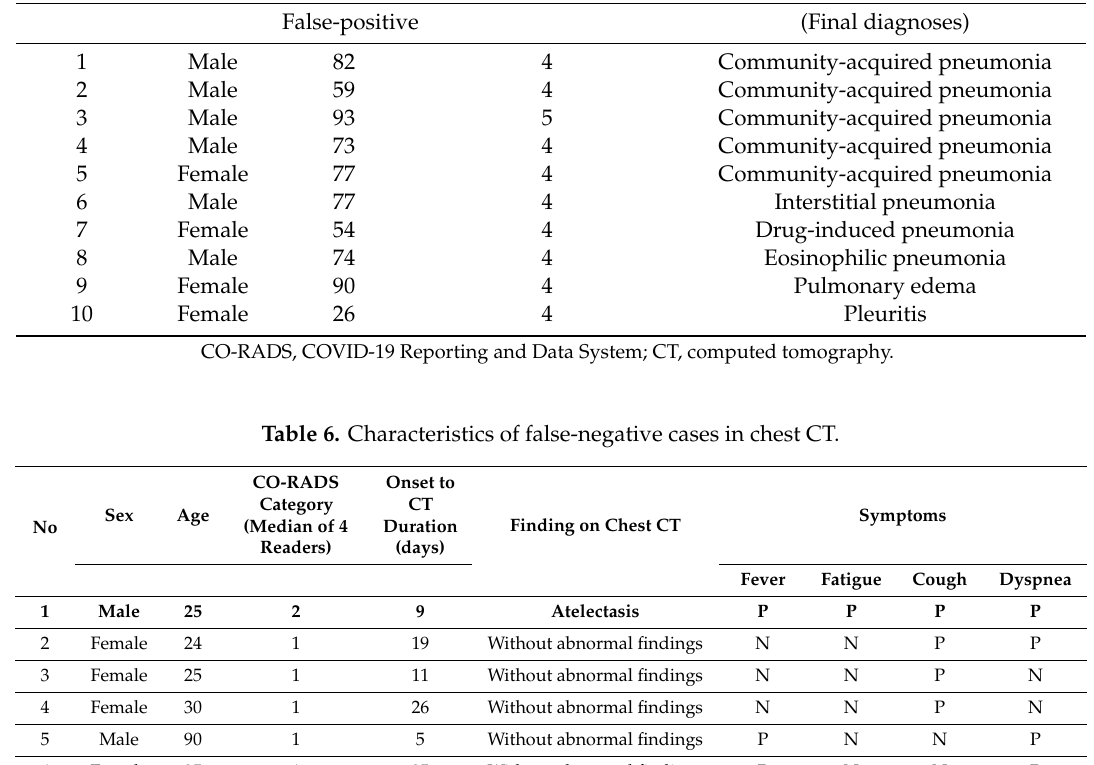
Figure 7. Example of a false-positive case (Case 2 ). Fifty-four-year-old female. The CT images show bilateral, peripheral posterior ground-glass opacities with consolidation with a lower lobe predominance. RT-PCR was negative for SARS-CoV-2. She had a history of medication use and was diagnosed with drug-induced pneumonia. Readers 1, 2, 3, and 4 diagnosed it as Categories 5, 4, 4, and 3, respectively. CT, computed tomography; RT-PCR, reverse transcription-polymerase chain reaction; SARS-CoV-2, severe acute respiratory syndrome coronavirus 2.